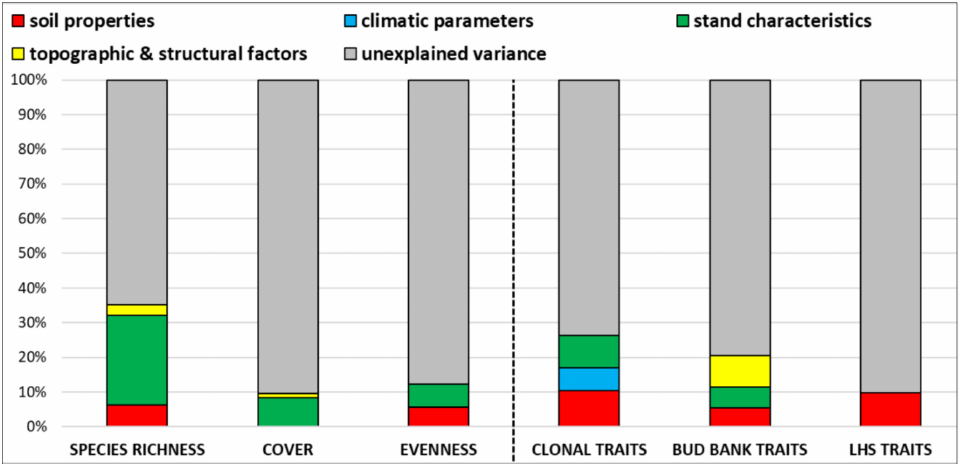
Figure 8. Variance partitioning (adjusted R 2 in %) from soil properties, climatic parameters, stand characteristics and topographic and structural factors for three taxonomy-based diversity measures (herb-layer species richness, cover, evenness) and trait-based measures (diversity of clonal, bud bank and leaf-height-seed (LHS) traits). The variance partitioning analysis was done based on predictors included in the final generalized additive models. For these, see Section